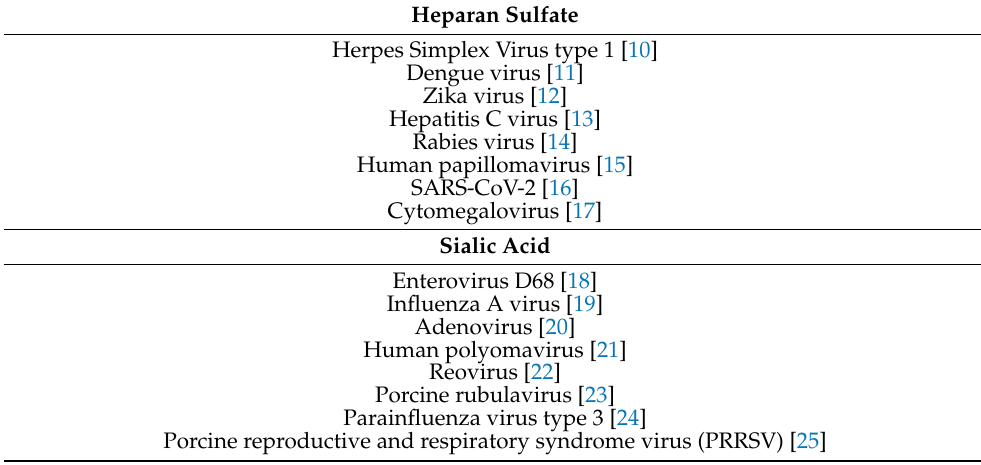
Table 1. Glycoconjugates involved in the viral